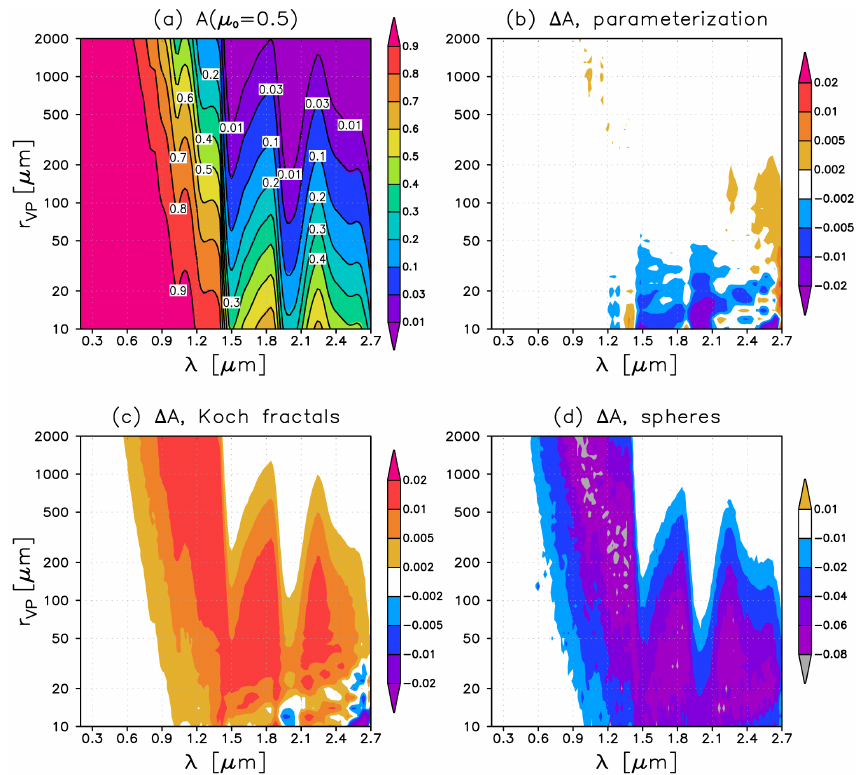
Figure 11. Albedo of a semi-infinite snow layer for direct incident radiation with the cosine of zenith angle µ 0 = 0.5. (a) Reference values computed for the OHC (shading) and values for the full snow optics parameterization (contours). The difference (b) between the parameter- ization and the reference, (c) between distorted Koch fractals ( t = 0.18) and the reference and (d) between spheres and the reference. Note that the colour scale differs between the figure